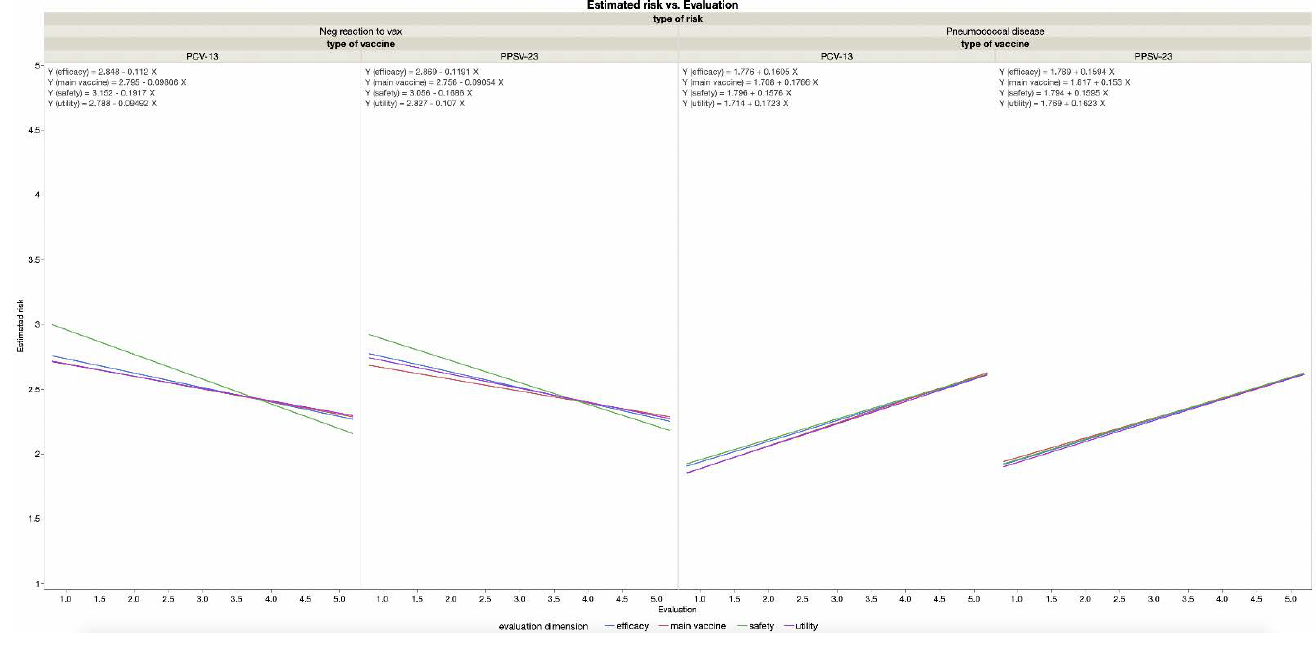
Figure 2. Participants’ estimated risk of getting sick and of negative reactions to vaccination, in relation to evaluations of PCV-13 and PPSV-23.